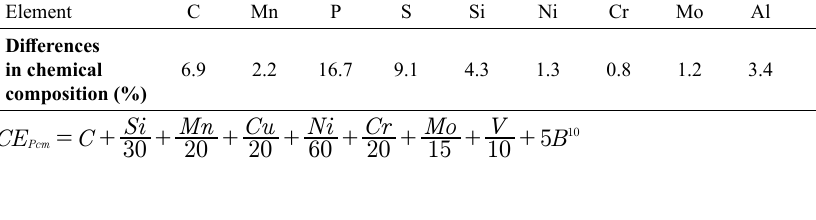
Table 1. Differences in chemical composition of position 2 relatively to position 1. Element